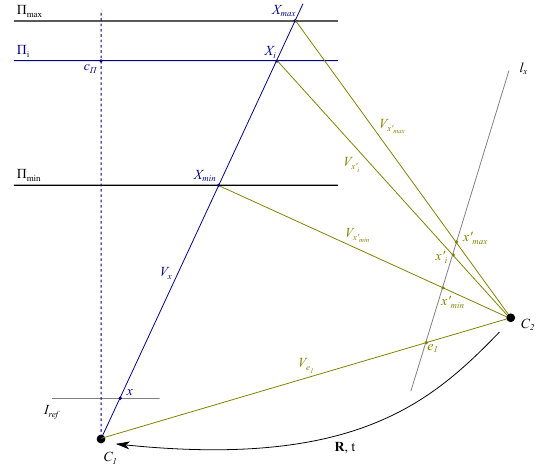
Figure 2. The use of the cross-ratio to determine the dis- tance parameter of the sampling